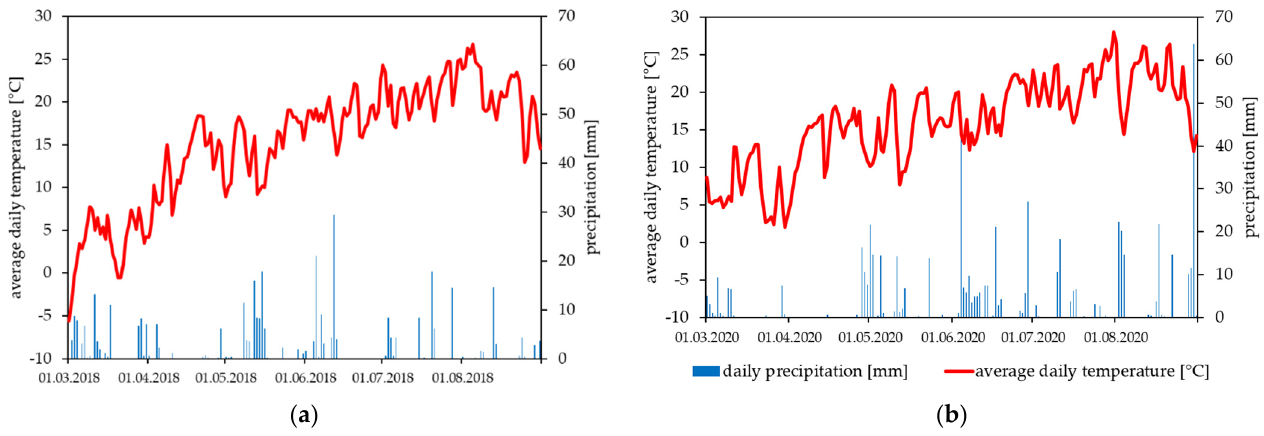
Figure 5. Meteorological data for the field trials Goumoens-la-Ville (VD, Switzerland) 2018 ( a ) and Reckenholz (ZH, Switzerland) 2020 ( b ). Average daily temperature (°C) and daily precipitation (mm) are given over a period, including the potato cultivation period.